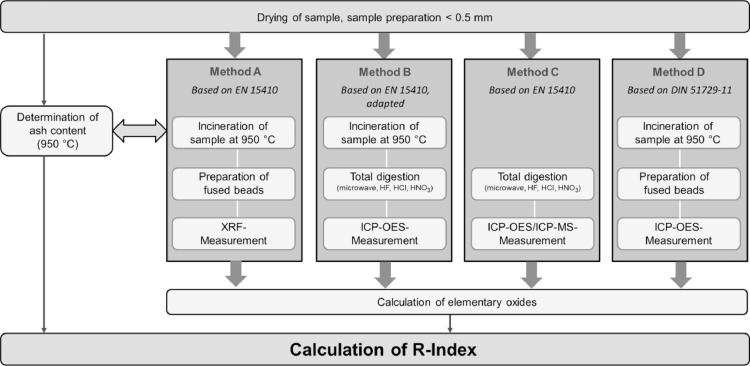
Overview on the different analytical approaches for the determination of the R-Index.